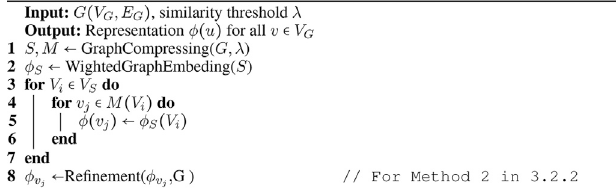
Algorithm 2: NECL: Network Embedding on Compressed